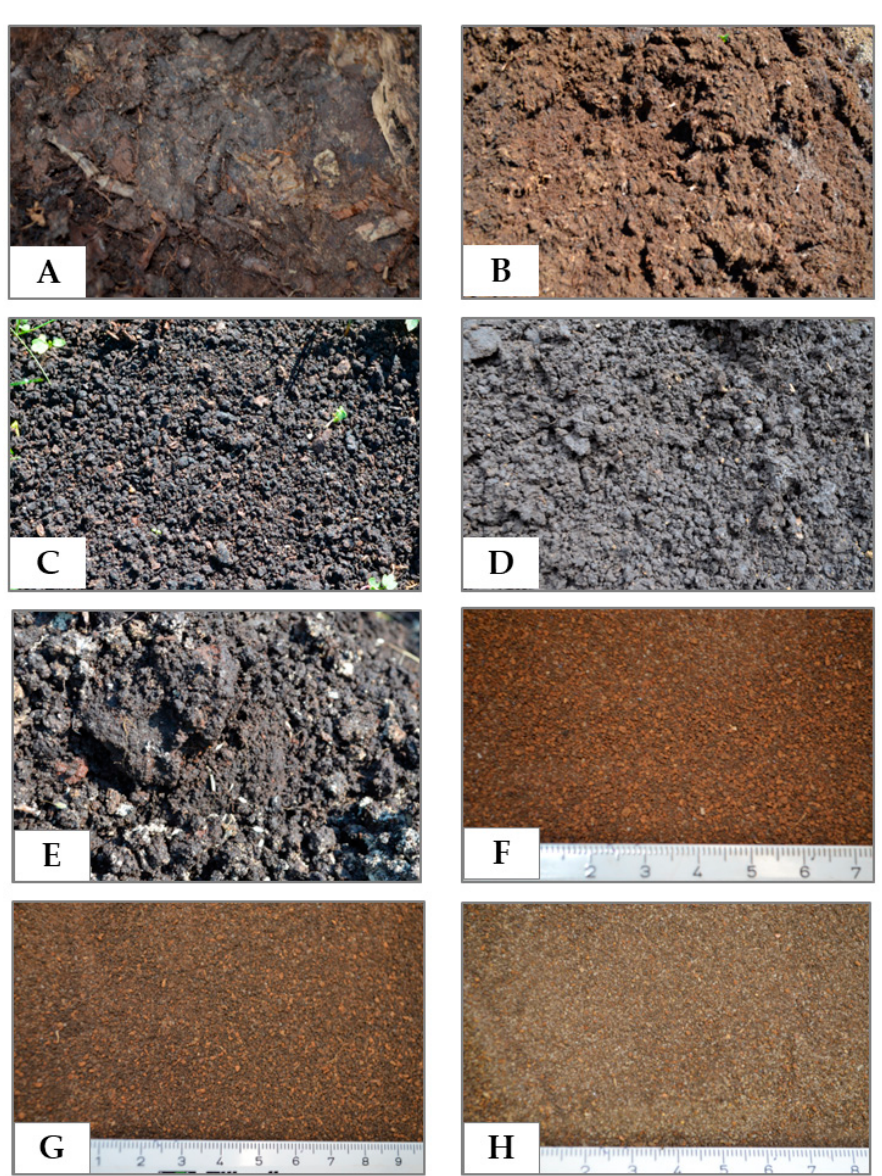
Figure 2. Examples of soil materials studied; ( A )—reed peat (medium degree of decomposition— hemic), 51.6% OC, visible white epiderms of Phragmites australis ; ( B )—sedge peat (weakly decomposed—fibric), 56.0% OC, visible rootlets of Carex sp.; ( C )—proper (grainy) mursh, 48.3% OC, (field conditions); ( D )—silted mursh, 26.8% OC (field conditions); ( E )—calcareous mursh, 25.7% OC, 30.7% CaCO 3 (field conditions); ( F )—ferruginous mursh, 22.9% OC, 25.9% Fe tot . (air-dried); ( G )—degraded (grainy) mursh, 40.5% OC, visible aggregates of various size and mineral particles covered by iron oxides (air-dried); ( H )—semimurshic soil material, 8.9% OC, dominance of whitish mineral particles of sand and silt size (air-dried).